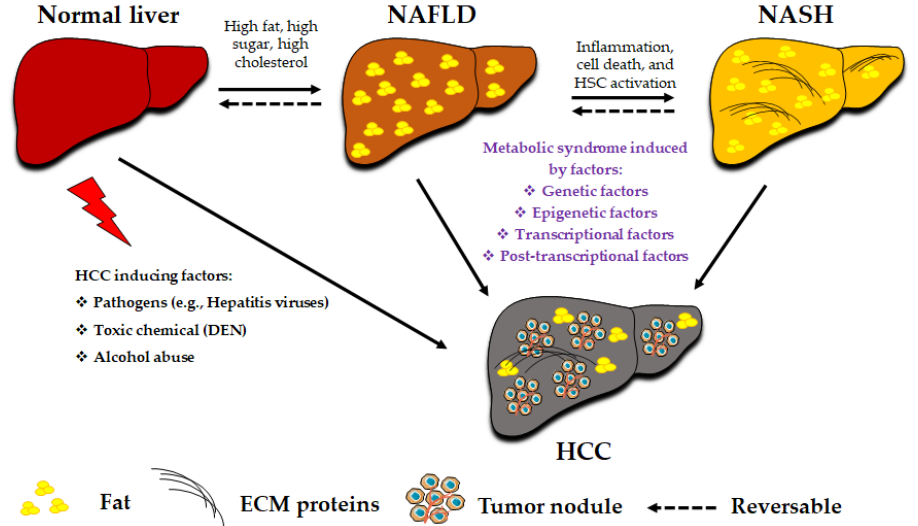
Figure 1. Factors causing the development and progression of NAFLD-related HCC and other etiologies causing HCC aside from NAFLD. Abbreviations: DEN: diethylnitrosamine; ECM: extra- cellular matrix proteins; HCC: hepatocellular carcinoma; HSC: hepatic stellate cell; NAFLD: nonalcoholic fatty liver disease; NASH: nonalcoholic steatohepatitis.